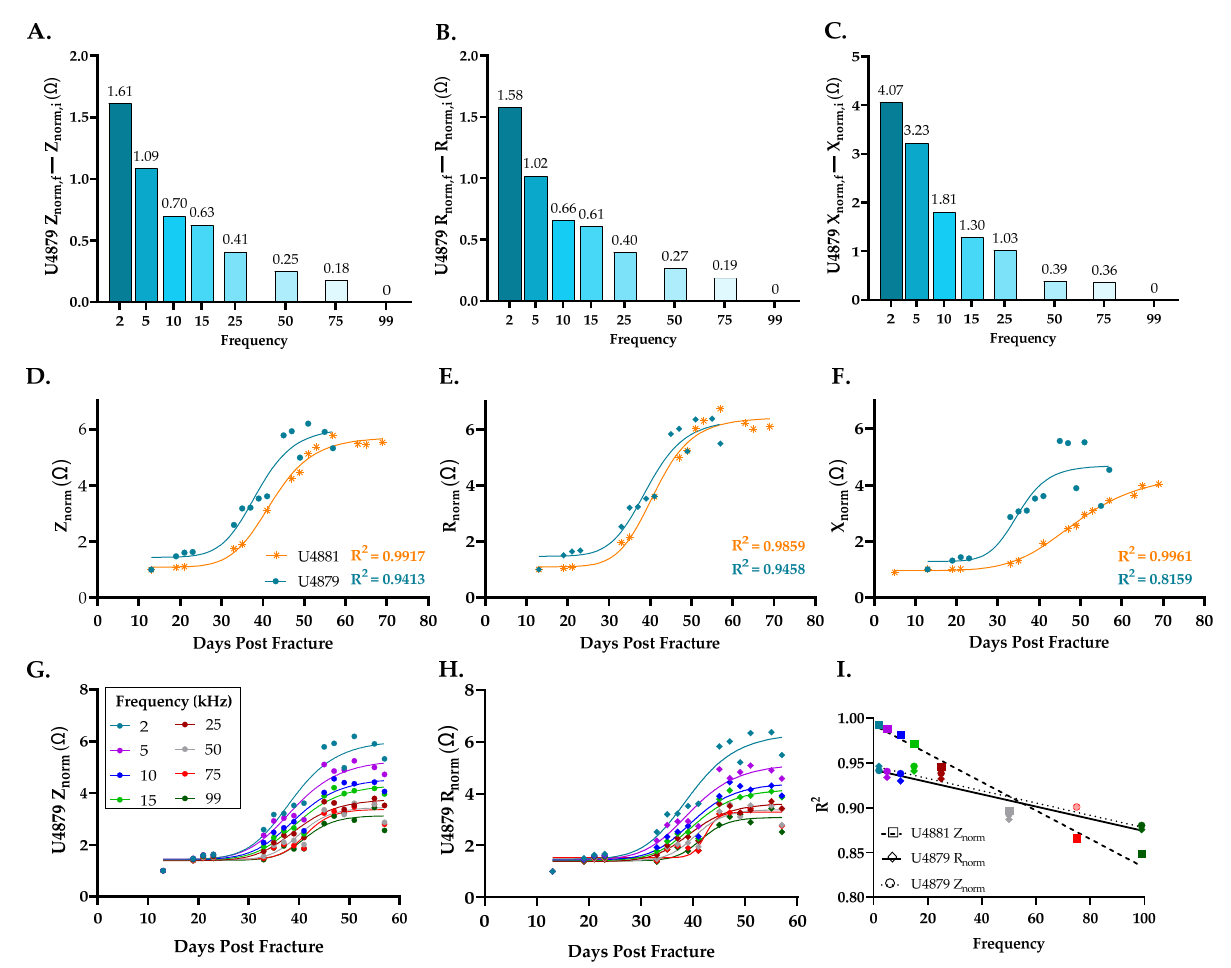
Figure 5. Normal fracture healing produces sigmoidal electrical responses at 2 kHz. ( A – C ) Difference in electrical measurements between final and initial recordings across all frequencies for sensor U4879 (blue). ( D – F ) Longitudinal electrical output at 2 kHz for sensor U4879 (blue) and U4881 (orange). ( G , H ) Electrical measurements across 2–99 kHz frequency sweep (colors indicated in ledged) for sensor U4879. ( I ) Goodness of fit (R 2 ) to a sigmoidal curve for sensors across 2–99 kHz frequency sweep (colors indicated in ledged in